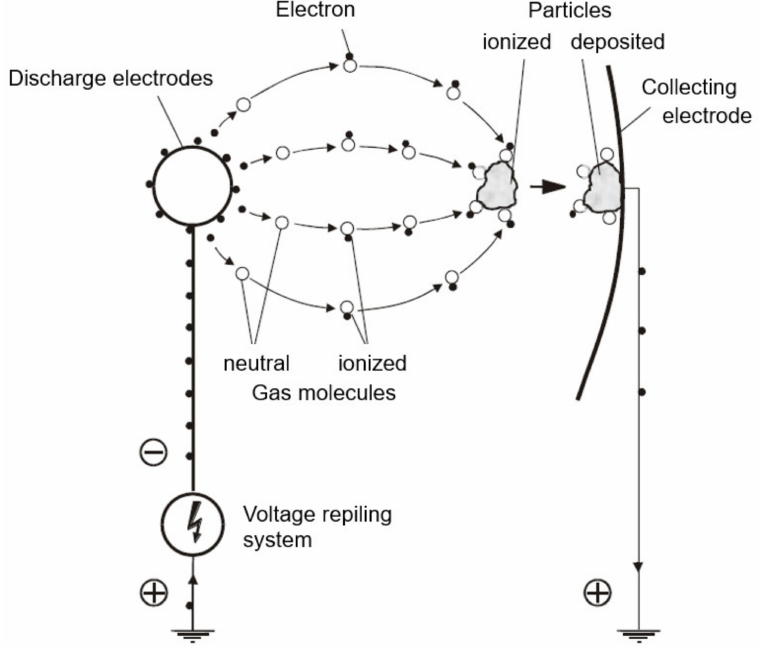
Figure 21. Principle of particle separation by using electrostatic precipitators (ESP) [37] (translated into English). Reprint with permission from Gaderer, M. et al. (2016). Direkte thermo-chemische Umwandlung (Verbrennung). In: Kaltschmitt, M., Hartmann, H., Hofbauer, H. (eds) Energie aus Biomasse; Copyright 2016, Springer Vieweg, Berlin,